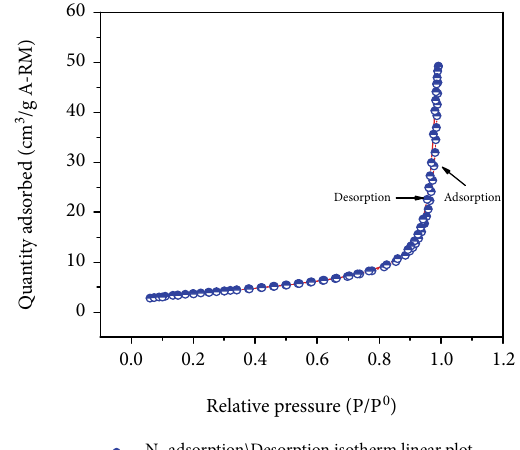
Figure 3: Isothermal plots of N